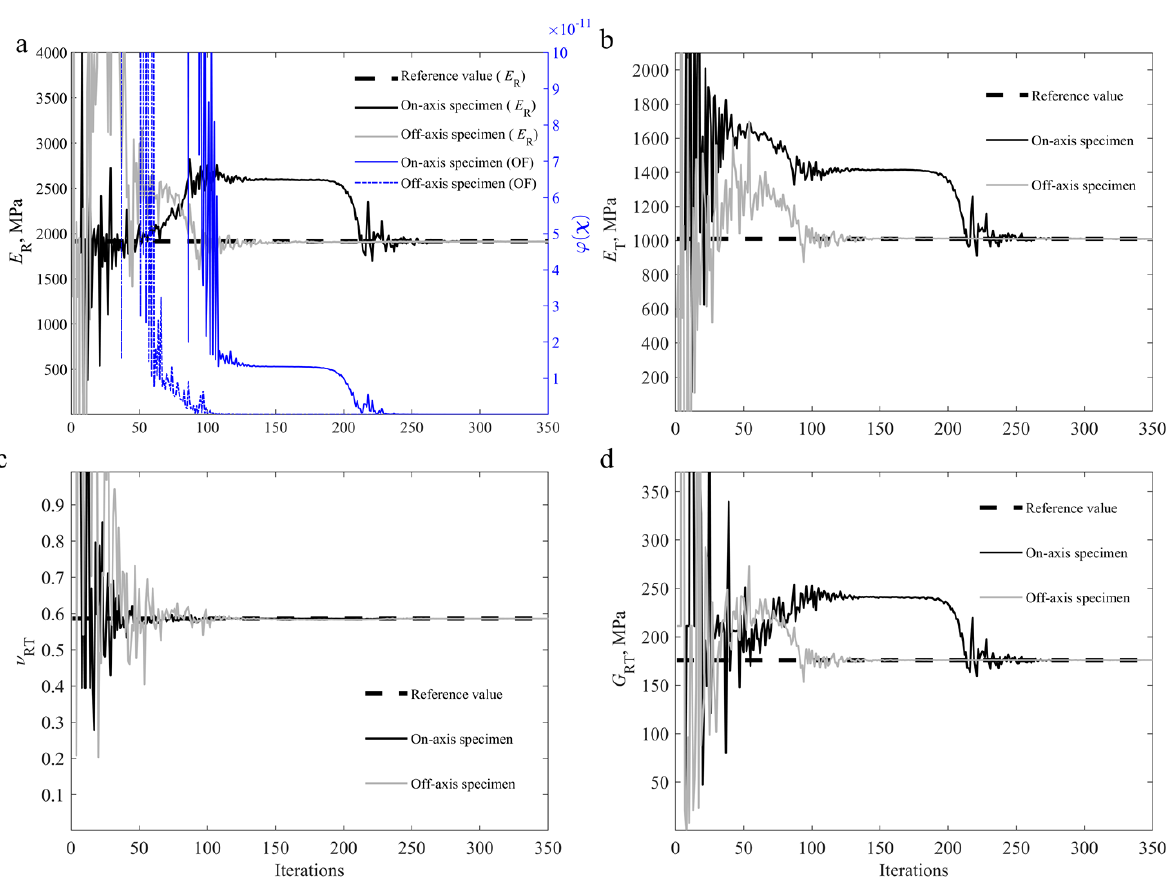
Figure 6. Convergence study for an on-axis specimen and off-axis specimen using a DIC-levelled FEA reference with reference parameters [2,55], regarding: ( a ) E R and ϕ ( χ ) ; ( b ) E T ; ( c ) ν RT ; ( d ) G RT